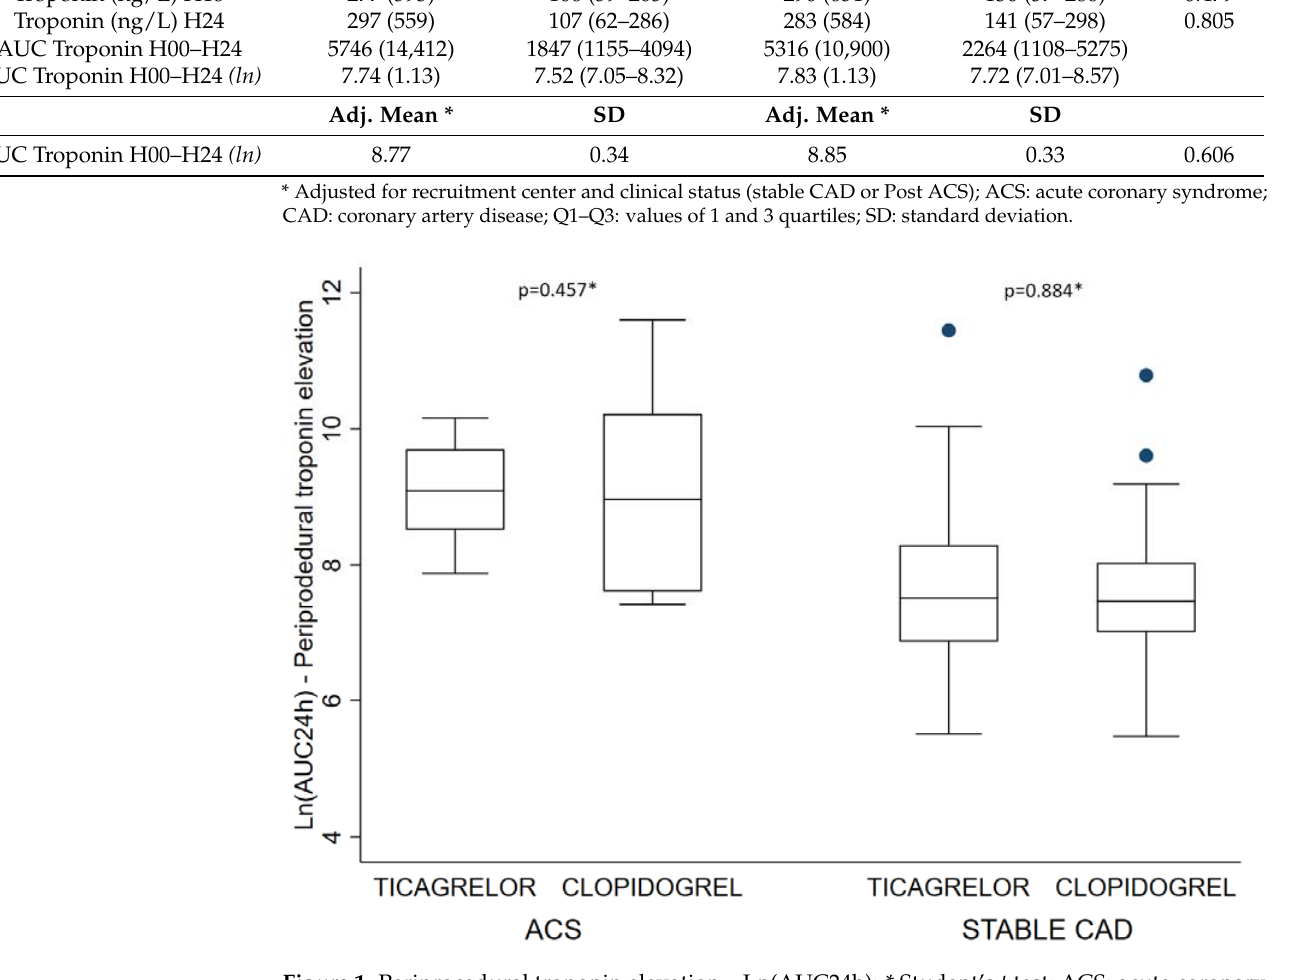
Figure 1. Periprocedural troponin elevation—Ln(AUC24h): * Student’s t test; ACS: acute coronary syndrome; AUC: area under the curve; CAD: coronary artery disease. Table 4. Multivariate analysis of factors associated with troponin elevation (Ln(AUC24h))—multiple linear